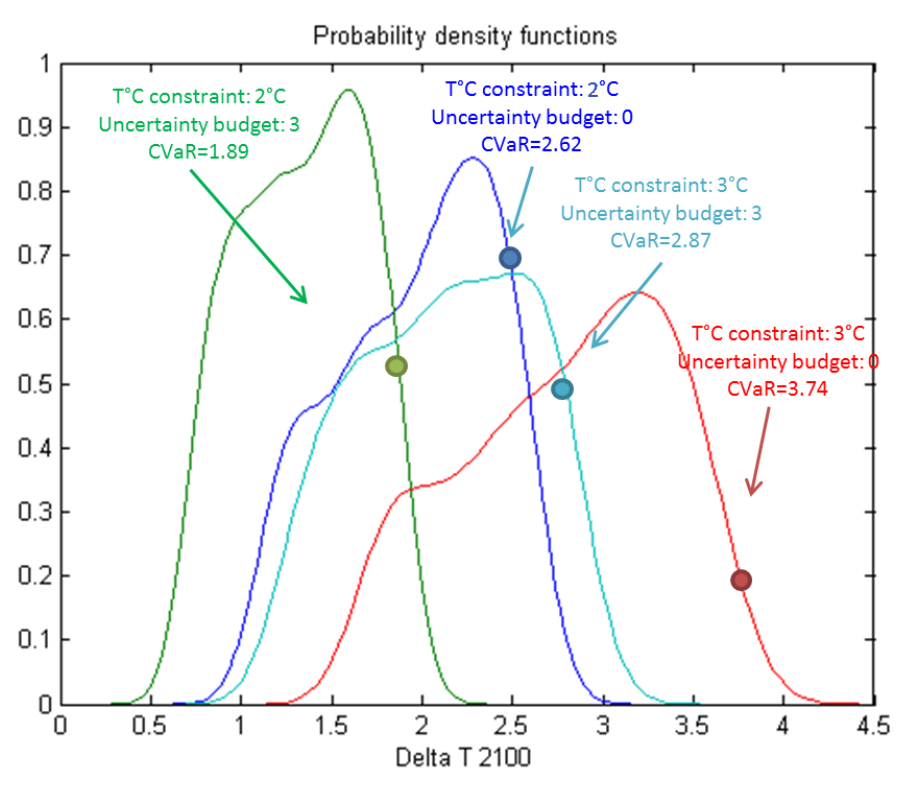
Figure A5. 2100 Temperature delta (2 ◦ C and 3 ◦ C emission pathways with Γ = 0 and Γ = 3)— Density functions and